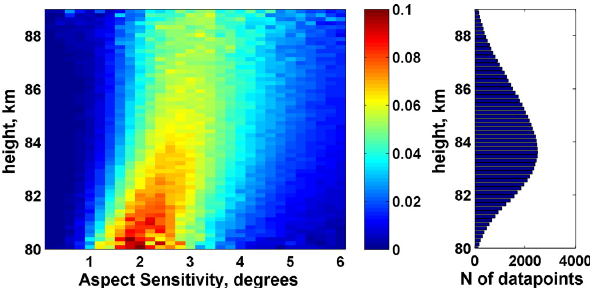
Fig. 5. Left panel: distribution of aspect sensitivity parameter for each 150-m altitude interval averaged over all 11 years. Each row is normalized so that the sum of all data bins in it is 1. Right panel: number N of data points contributing to each altitude